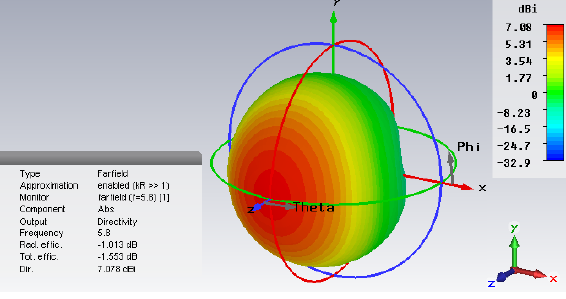
Figure 13. Far field region for Taconic RF 35P.